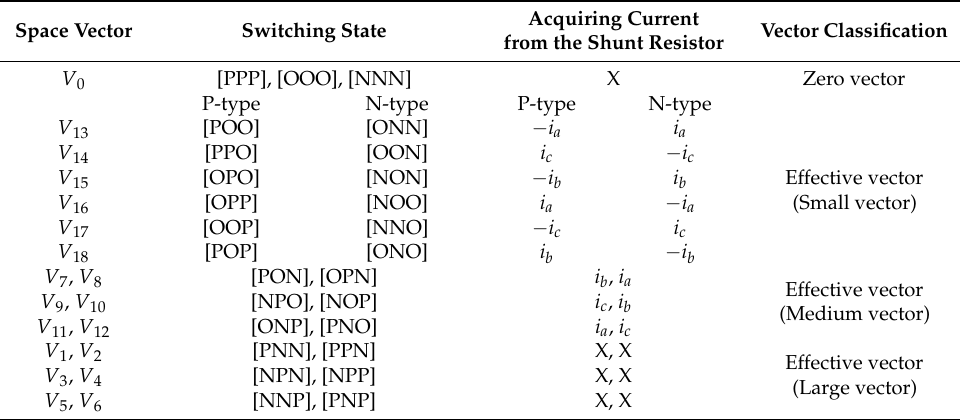
Figure 4. Three-level neutral shunt inverter effective-voltage vector hexagon. Table 1. Switching states and acquiring the phase current from the shunt resistor.